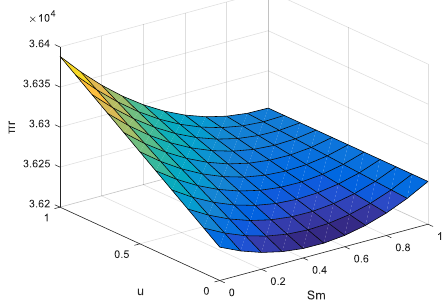
Figure 7. Effect of s m and µ on π r .